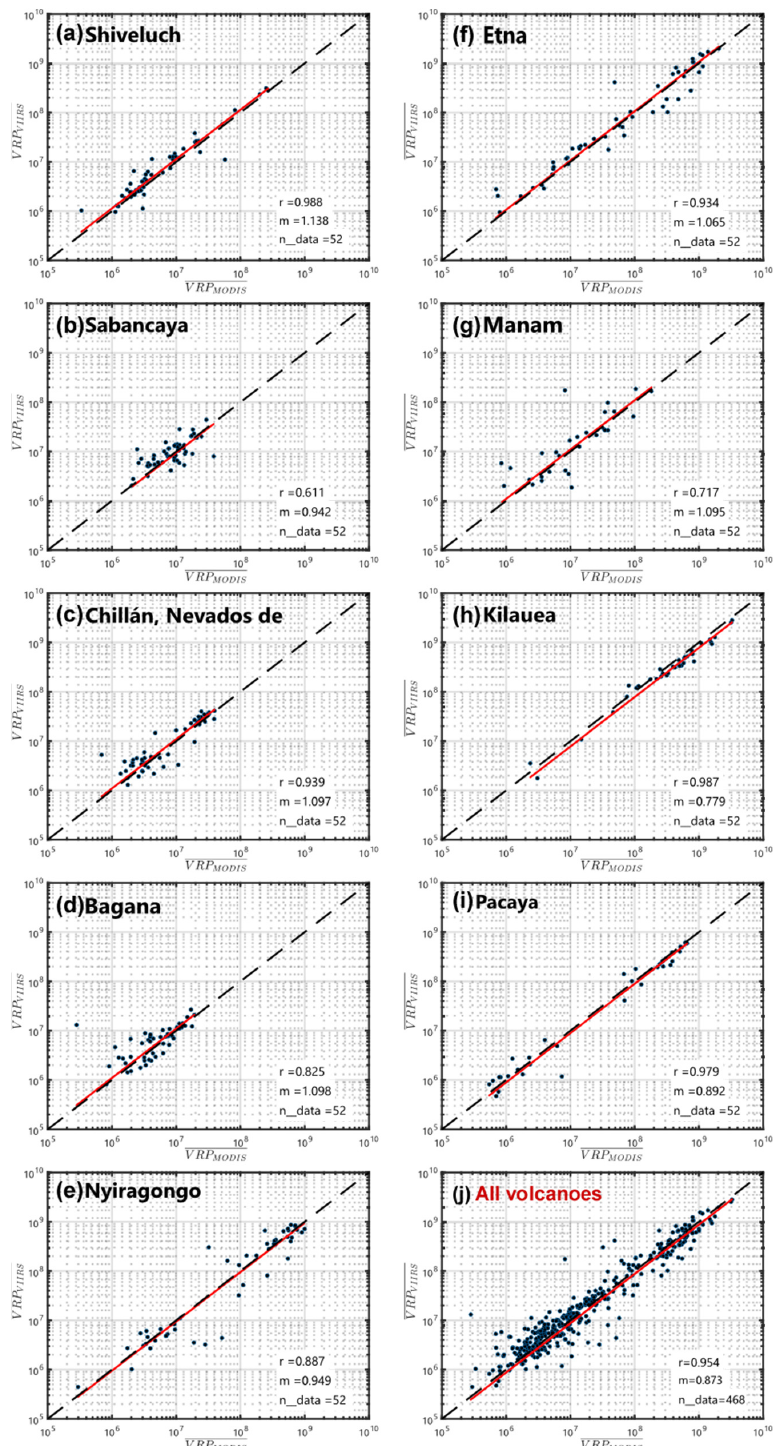
Figure 11. Linear regressions VIIRS and MODIS-derived VRPw (weekly mean) of subaerial volcanoes: ( a ) Shiveluch, Russia; ( b ) Sabancaya, Peru; ( c ) Nevados de Chill á n, Chile; ( d ) Bagana, Papua New Guinea; ( e ) Nyiragongo, D.R. Congo; ( f ) Etna, Italy; ( g ) Manam, Papua New Guinea; ( h ) Kilauea, Hawaii; ( i ) Pacaya, Guatemala. ( j ) Whole dataset (9 volcanoes). Red lines represent the best-fit linear correlation whose coefficients m and r are reported in each graphic. Black dashed lines are the 1:1